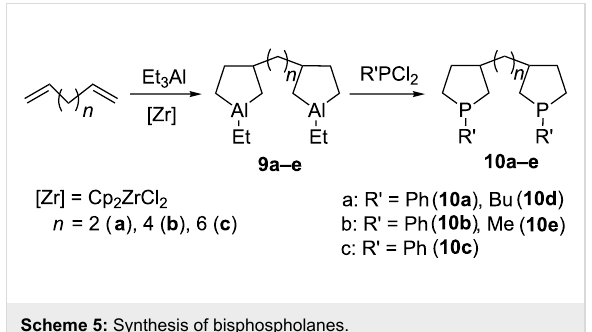
Scheme 5: Synthesis of